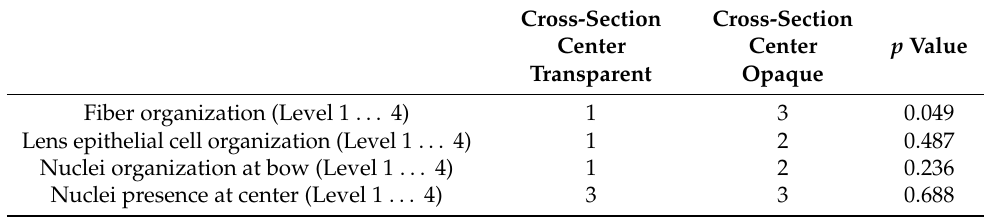
Table 4. Comparison morphological organization among our samples when separating them in to two groups based on the central transparency of their cross-sections. The median levels of organization (Level 1 . . . 4) of the different morphological factors of each sample group were compared. Statistical significance of median results was calculated with the Kruskal-Wallis test. Cross-Section Cross-Section p Value Center Center Opaque Transparent Fiber organization (Level 1 . . . 4) 1 3 0.049 Lens epithelial cell organization (Level 1 . . . 4) 1 2 0.487 Nuclei organization at bow (Level 1 . . . 4) 1 2 0.236 Nuclei presence at center (Level 1 . . . 4) 3 3